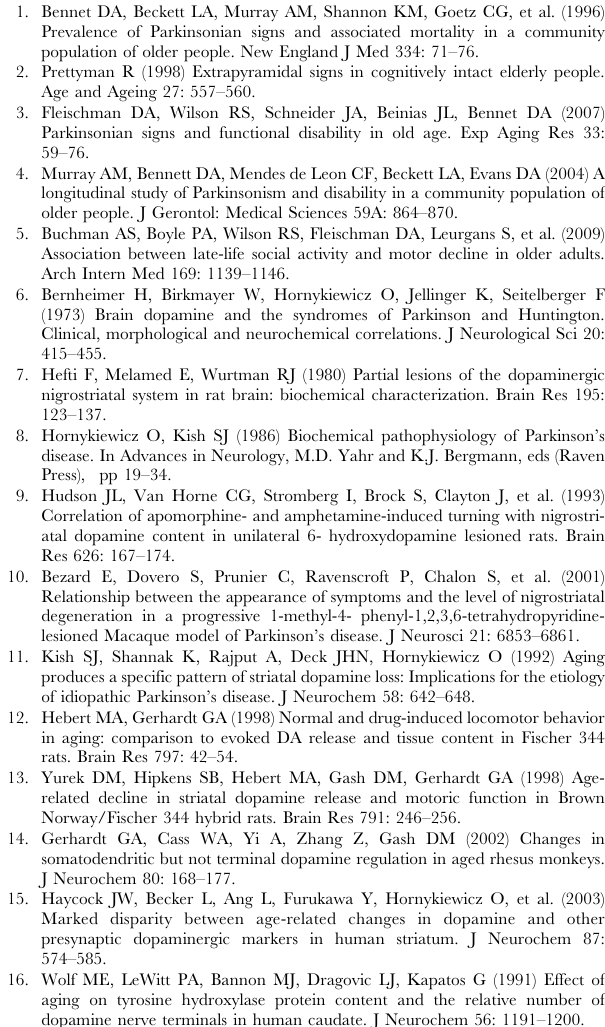
Table S1 Habituation of locomotion. Table S2 Mesoaccumbens pathway DA correlations